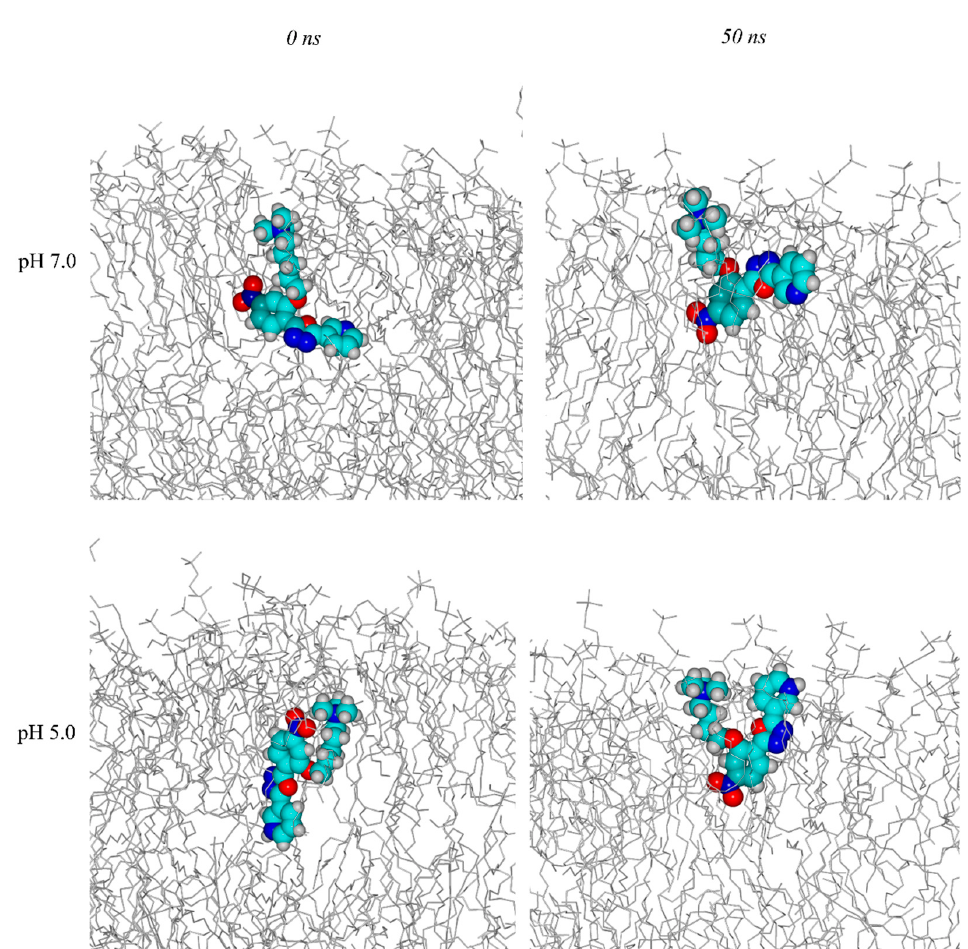
Figure 4. C1 in POPC membrane at 0 ns, at pH = 7.0 and pH = 5.0; at 50 ns, at pH = 7.0 and pH = 5.0.